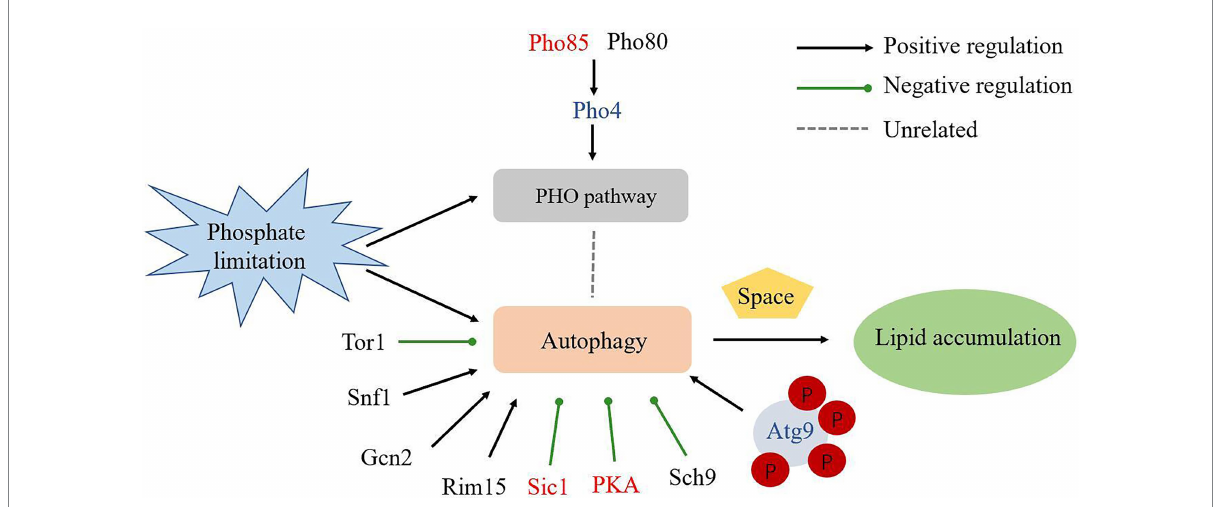
FIGURE 7 Schematic overview of the regulation of autophagy and lipid accumulation under phosphate limitation in R . toruloides . Up-regulated proteins were in red; not changed proteins were in black; not detected proteins were in